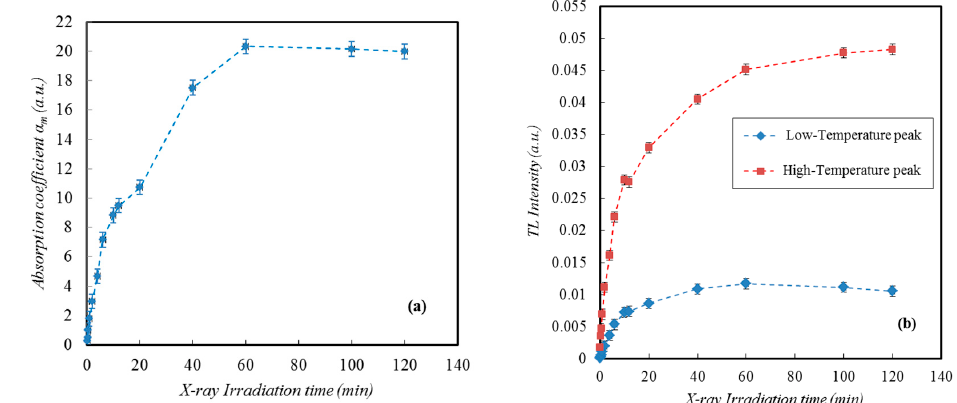
Figure 7. Variations of ( a ) absorption coefficient at about 560 nm wavelength of absorption spectrum and ( b ) each peak of TL glow curve of X-ray irradiated KCl:Eu 2+ (0.04 mol%) single crystals with the irradiation time. The dotted lines are to guide the reader’s eye.